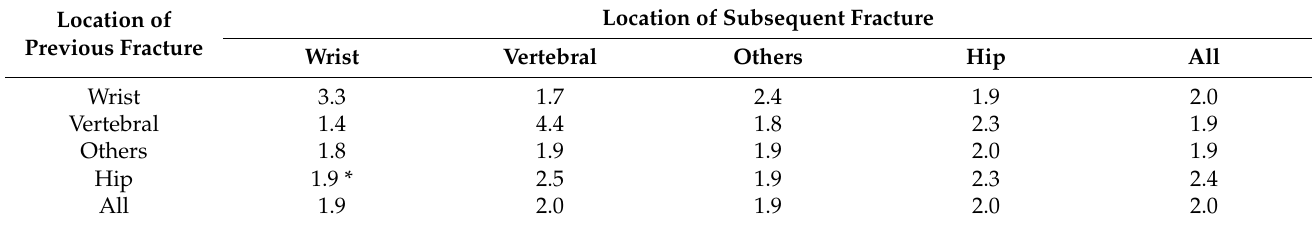
Table 2. Relative risk of experiencing a second osteoporotic fracture according to previous type of fracture in peri/post- menopausal